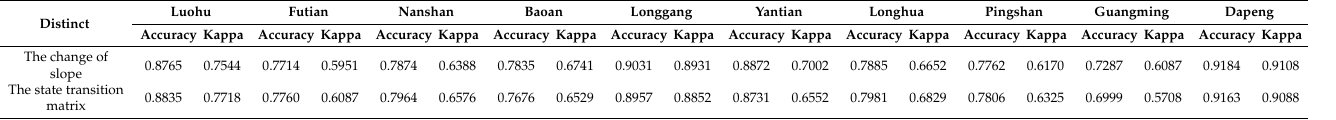
Table 5. The experimental results of various districts in Shenzhen using different diffusion coefficients. Luohu Distinct slope